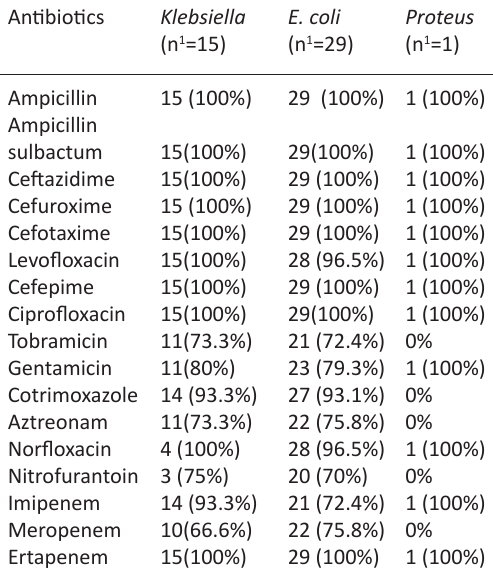
Table 1. Co-resistance pattern of ertapenem resistant isolates.